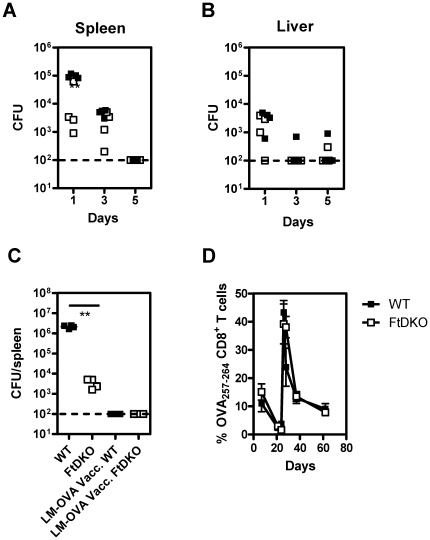
LM-OVA clearance and re-challenge response.Bacterial burden in the spleen (A), and liver (B) of individual mice on different days post-infection (n = 4/time point/group) following intravenous 104 LM-OVA infection. **, P = 0.0029 by two-tailed t test with Welch's correction for unequal variance. In a separate experiment, mice vaccinated with 104 LM-OVA were re-challenged 21 days later with 105 LM-OVA, (C & D). Splenic bacterial burden on day 3 following 105 LM-OVA infection (C), n = 4/group. **, P = 0.0013 relative to C57BL/6J by two tailed t-test with Welch's correction for unequal variance. The frequency of blood OVA257–264-specific CD8+ T cells was determined (D) following primary exposure to 104 LM-OVA and re-challenge on day 21 with 105 LM-OVA (n = 3/group).